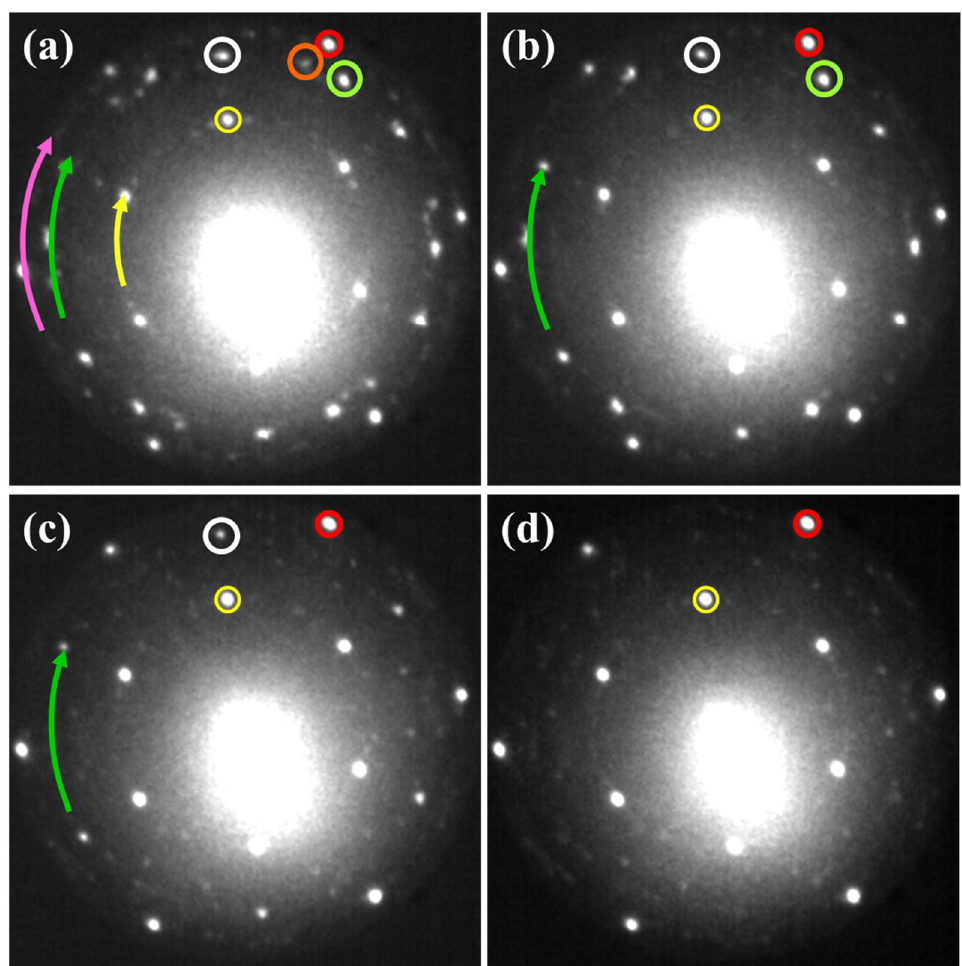
Figure 7. LEED patterns illustrating a process of degradation of low buckled (pink arrow) and planar (green arrow) phases of silicene: 540 K ( a ), 550 K ( b ), 560 K ( c ), 565 K ( d ). Twenty-four main diffraction spots of planar silicene as a consequence of destructive annealing are reduced to 18 spots (3 domains marked by white, orange and green circle ( a )), and further to 12 diffraction spots (2 domains ( b —white and green circle)) and 6 diffraction spots (1 domain ( c —white circle)). Simultaneous decrease of intensity of (√3 √3) periodicity denoted to mutual rotation of both silicene phases and in the same time increase of sharpness and intensity of the (1 × 1) and (√3 × √3) diffraction spots of Si substrate was observed, yellow arrow, red and yellow circles, respectively. At 565 K, mainly substrate with (1 × 1) and (√3 × √3) spots remained ( d ). All patterns were recorded at E = 14.2 eV.